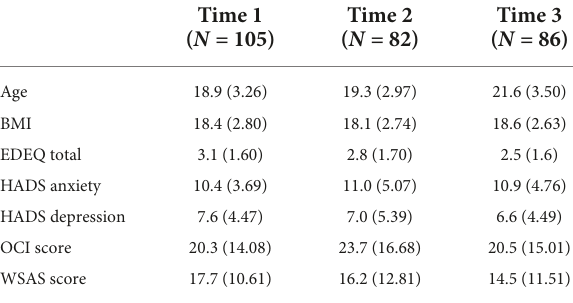
TABLE 1 Clinical and demographic sample characteristics.